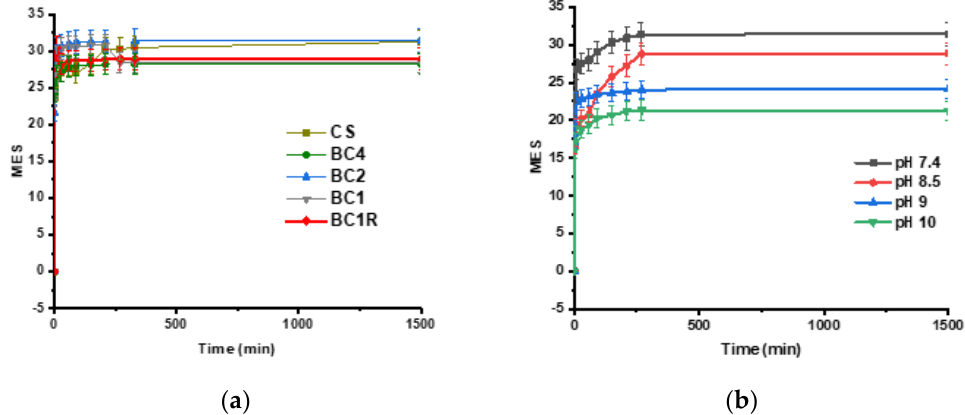
Figure 7. Swelling kinetics of ( a ) fibers in water and ( b ) representative BC1R sample in PBS of different pH.